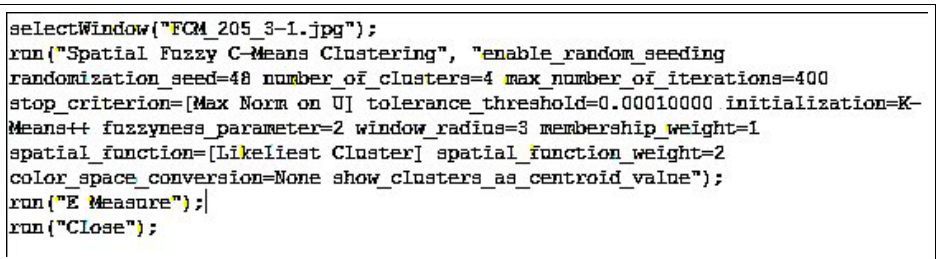
Figure 2. An example of macro in the developed